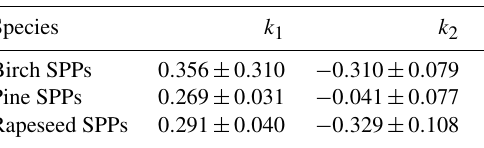
Figure 9. Growth factors observed in hydration and dehydration experiments (a, c, e) and g b -based hygroscopicity parameter, κ b (Eq. 7) (b, d, f) of birch, pine, and rapeseed subpollen aerosol particles with D b, H&D , min ∼ 95nm, respectively. Different symbols are different exper- imental runs. Inserts in panels (a) , (c) and (e) show the κ -Köhler curves with lowest and highest κ taken from the right panels. The vertical orange lines in panels (b) , (d) , and (f) mark the expected onset of LLPS, and the arrows show the experimental point with the maximum RH value obtained in each measurement. Table 4. Parameters characterizing the hygroscopic properties of subpollen particles with D b, H&D , min ∼ 95nm: best-fit values ( ± SD) for the three-parameter fit ( k 1 , k 2 , k 3 ; Eq. 9) and SRH of LLPS; n and R 2 are the number of data points and the coefficient of determination of the fit,